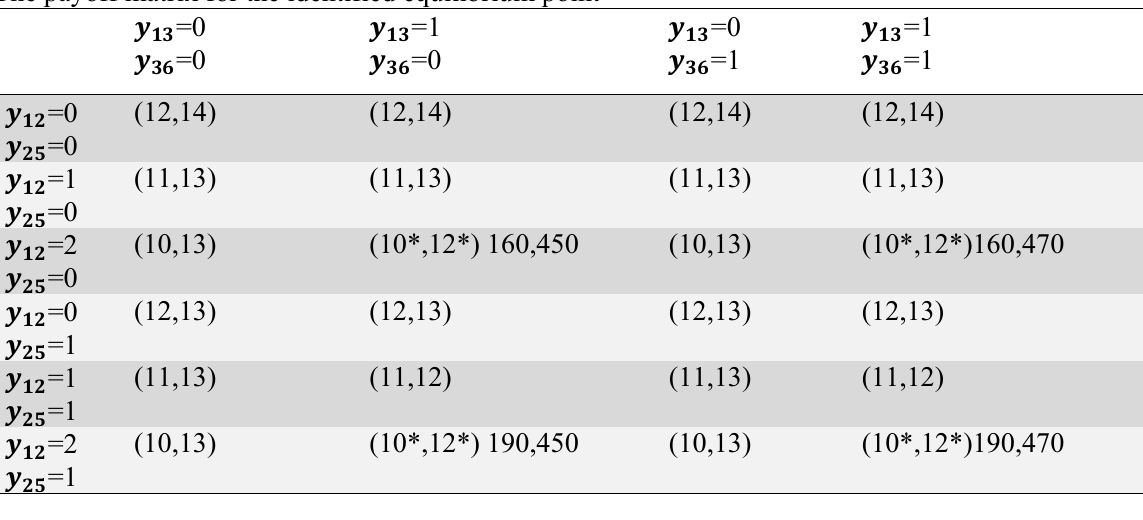
The payoff matrix for the identified equilibrium